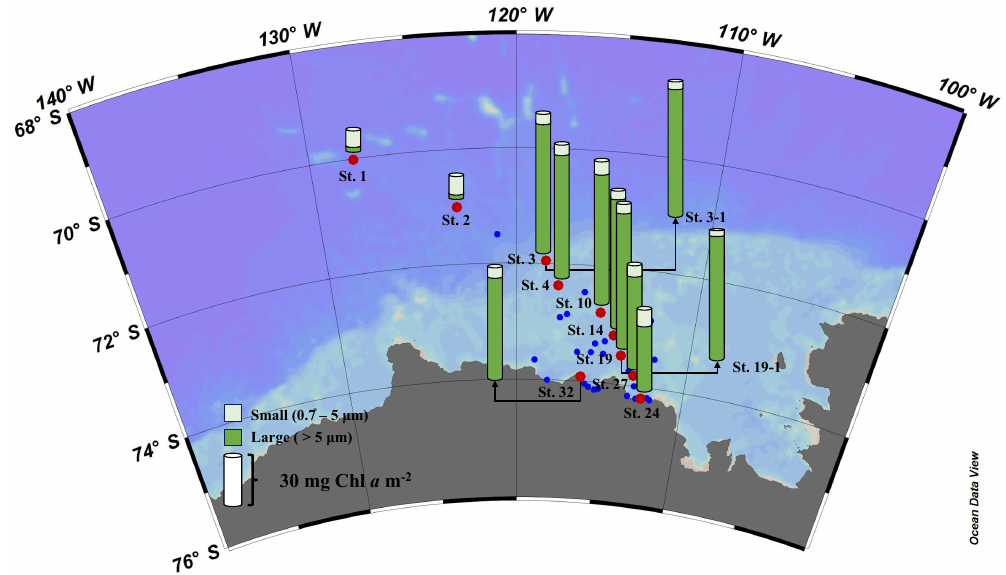
Figure 2. Water-column-integrated chlorophyll a concentrations (mgChl a m − 2 ) of small (0.7–5µm) and large (>5µm) phytoplankton at the productivity stations in the Amundsen